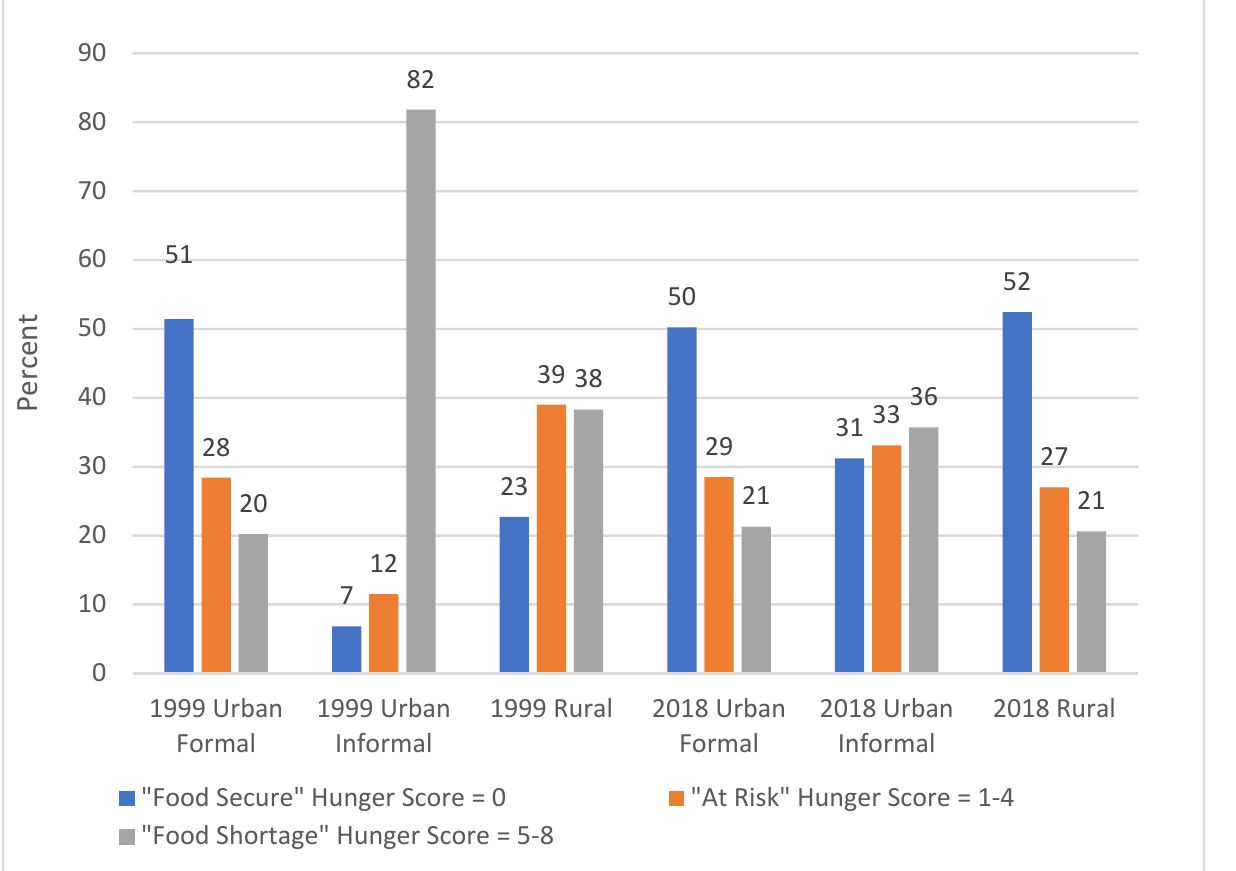
Table 5. Comparison of mean [95% CI] and median [95% CI] macronutrient intakes of children 1–<10 ‐ years ‐ old between 1999 and 2018. for Gauteng and Western Cape, by age group and overall.